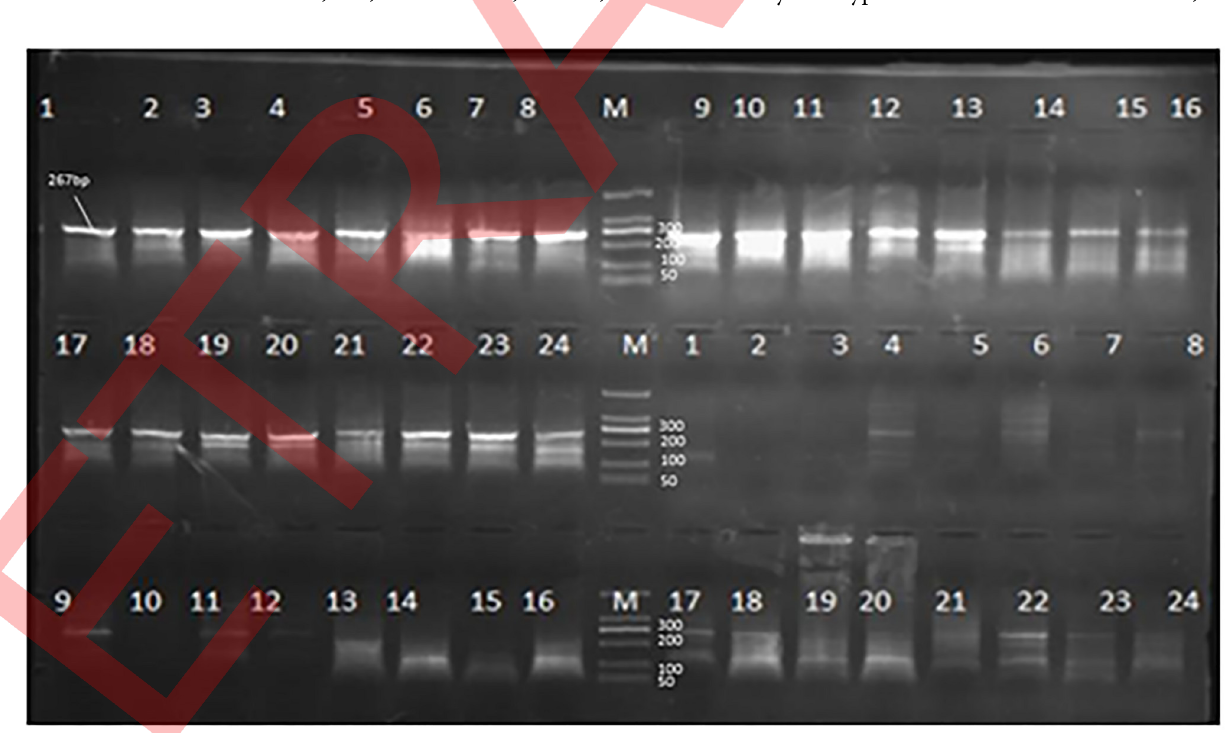
extracted was used for PCR amplification. The SPL14-14 region was amplified with CR and TR primers that resulted in 267bp amplicons (Fig 1, Table 3). Out of the 24 rice lines and varieties used, 5 had C type allele, whereas 19 contain heterozygous with a C-T allele. The ref- erence genome of SPL14 undergo both symmetric and asymmetric methylation therefore, C allele is a target nucleotide for methylation in the promoter region of the OsSPL14 gene, which regulates the expression level of a gene. The C-T substitution prevents methylation and may interfere with the transcription of gene through epigenetic phenomena. Basmati 370, IR9, Malkhar-346, Line 20, and Line 31 carry wild type C allele while Rachna basmati,